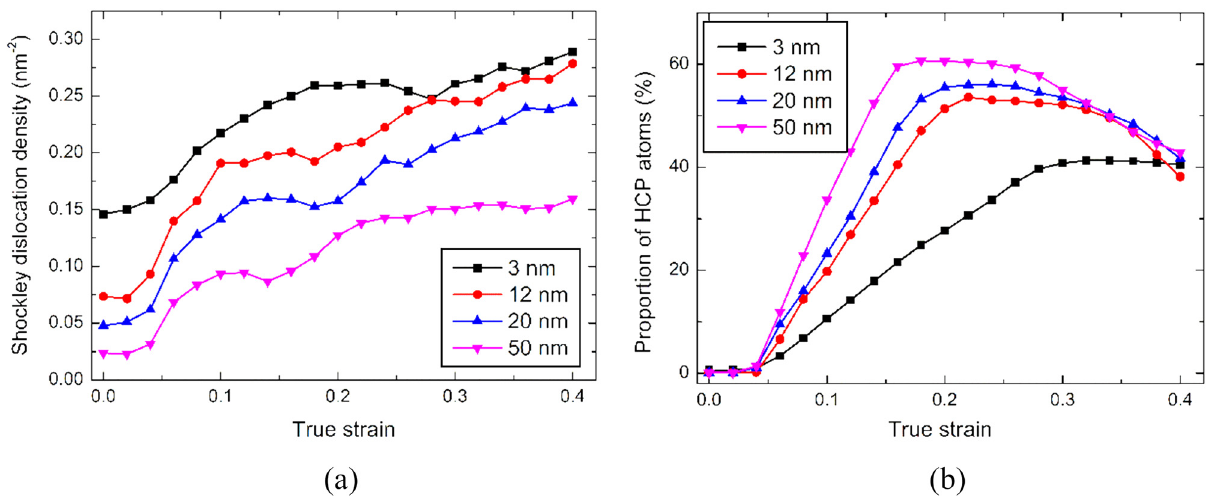
Figure 5: Variations of ( a ) Shockley dislocation density and ( b ) the proportion of HCP atoms during the uniaxial deformation.